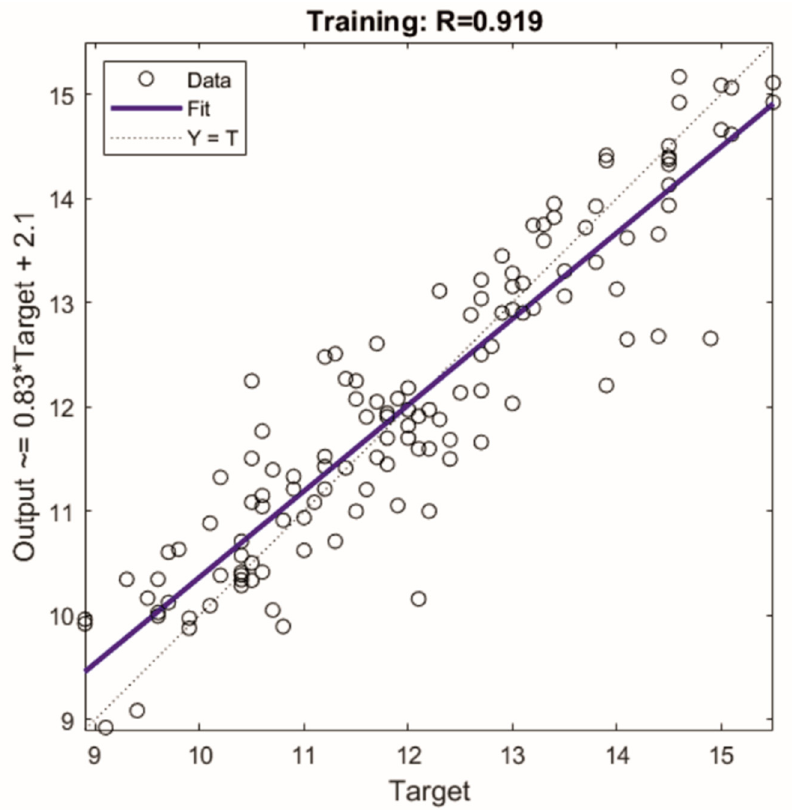
Figure 8. Training result for the stiffness modulus ANN model.